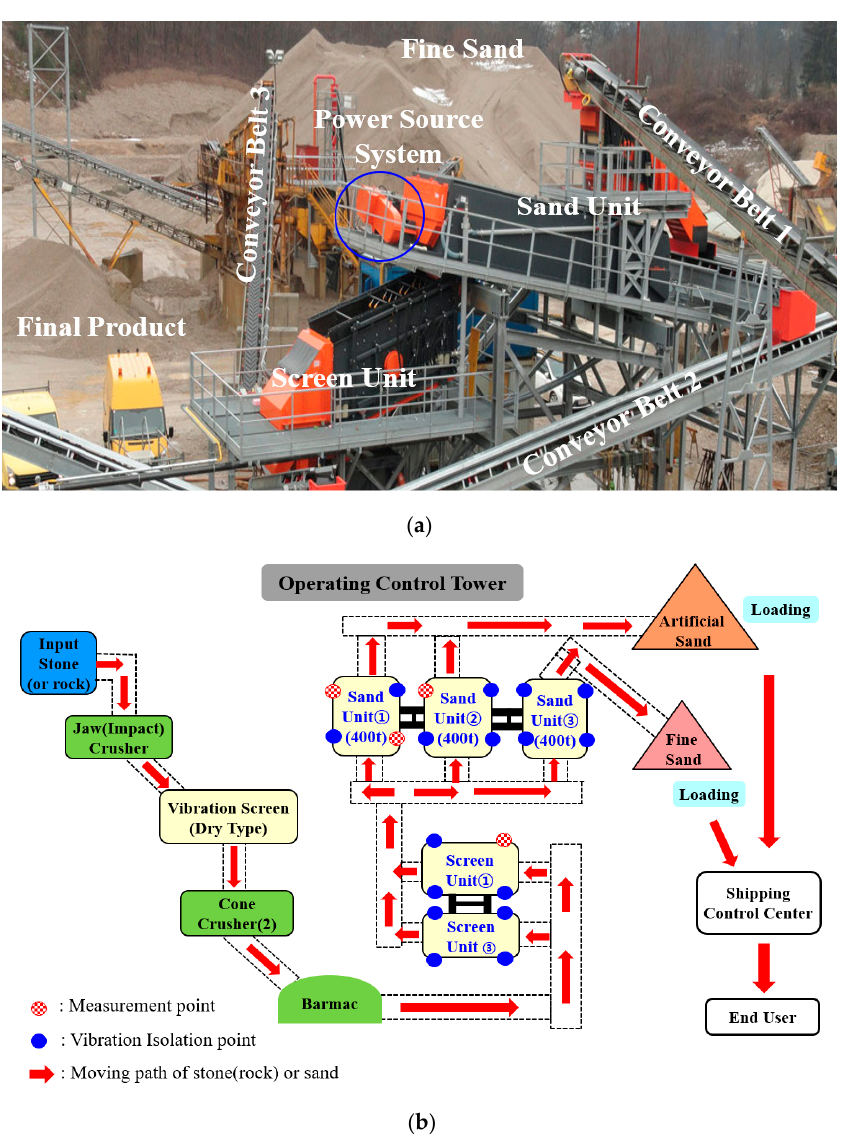
Figure 1. Artificial sand manufacturing plant and process: ( a ) Photograph of the artificial sand manufacturing plant; ( b ) Overall process of manufacturing in artificial sand production.